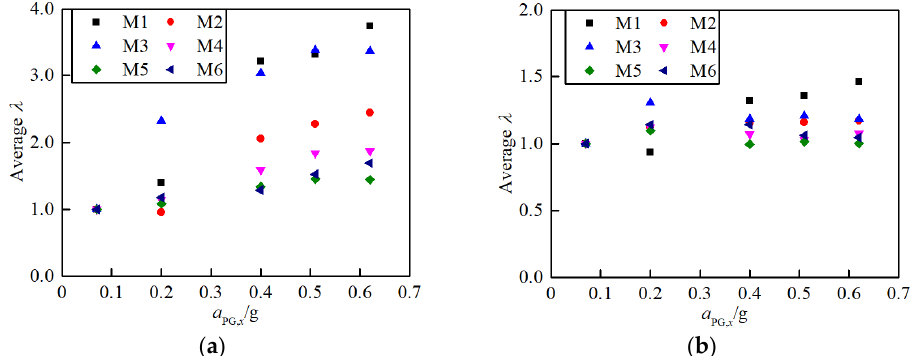
Buildings 2023 , 13 , x FOR PEER REVIEW 17 of 25